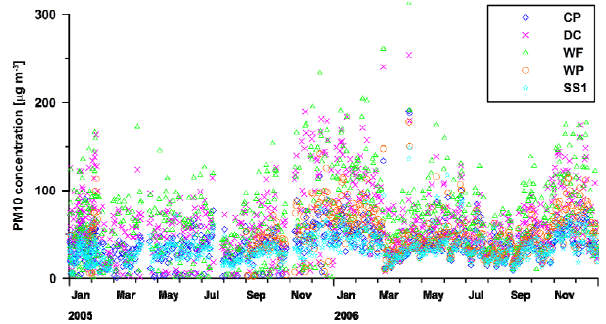
Fig. 1. 24-h averaged PM 10 from five permanent monitors in cen- tral Phoenix (Abbreviations: CP – Central Phoenix, DC – Durango complex, WF – West 43rd Avenue, WP – West Phoenix, SS1 –